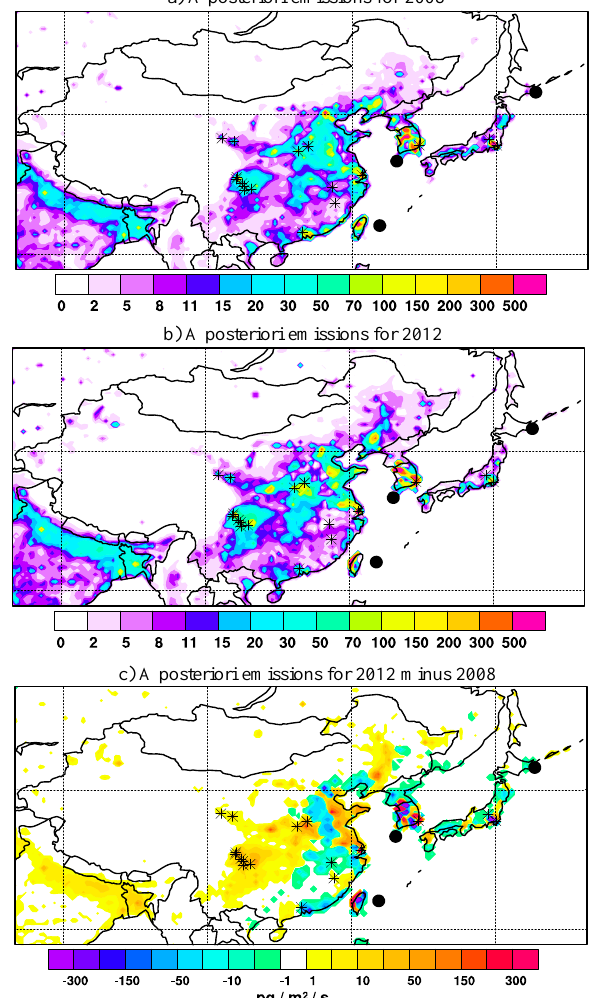
Fig. 8. Maps of the a posteriori SF 6 emissions for 2008 (top panel) and 2012 (middle panel), and difference between a posteriori emissions for 2012 and those for 2008 (bottom panel). Black dots denote the location of measurement stations. Asterisks mark the locations of factories in East Asia known to have produced SF 6 around the year 2008.